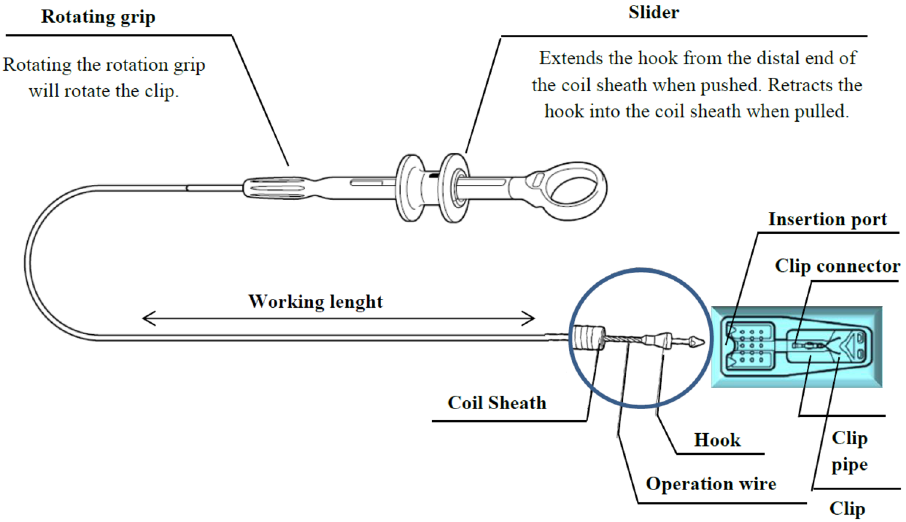
Figure 3. System for endoscopic deployment of modified clip at the point of interest into the gastrointestinal